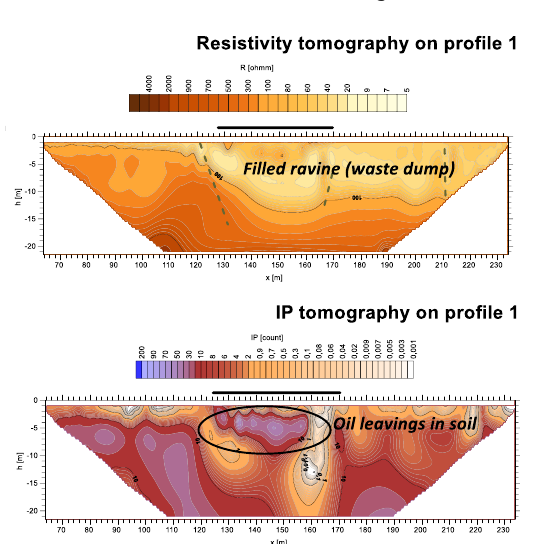
Figure 11. The resistivity cross section and IP tomography on the waste dump with oil leavings.